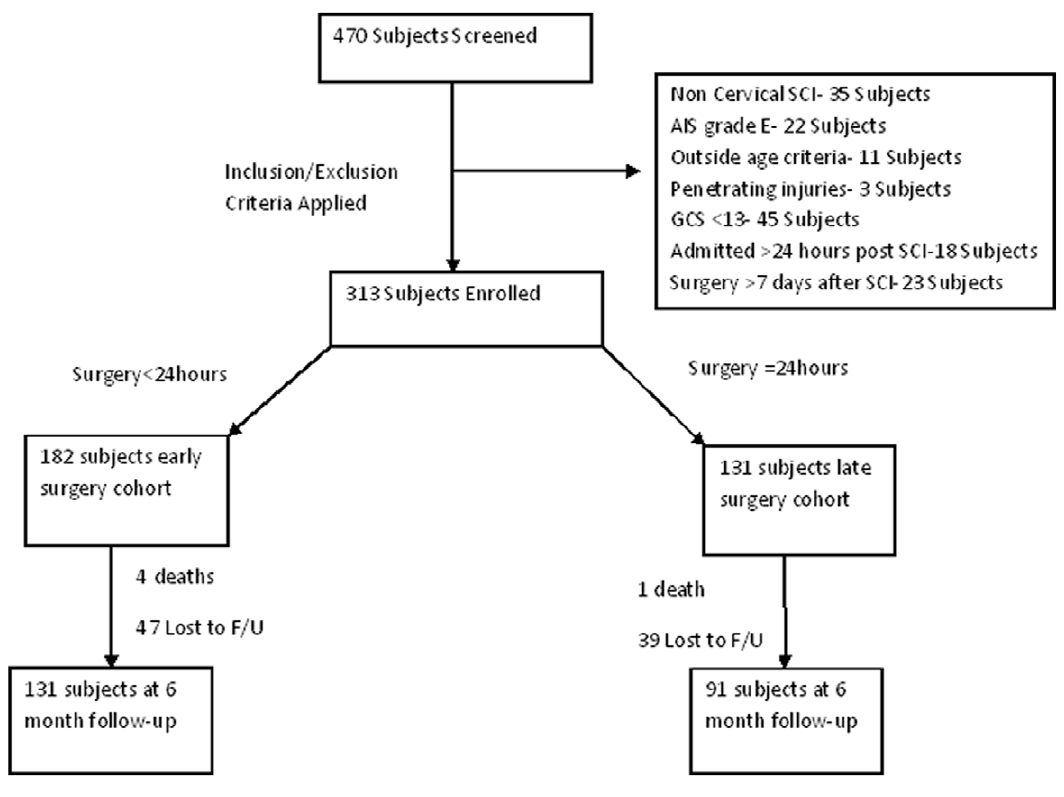
Figure 1. Patient Flow.